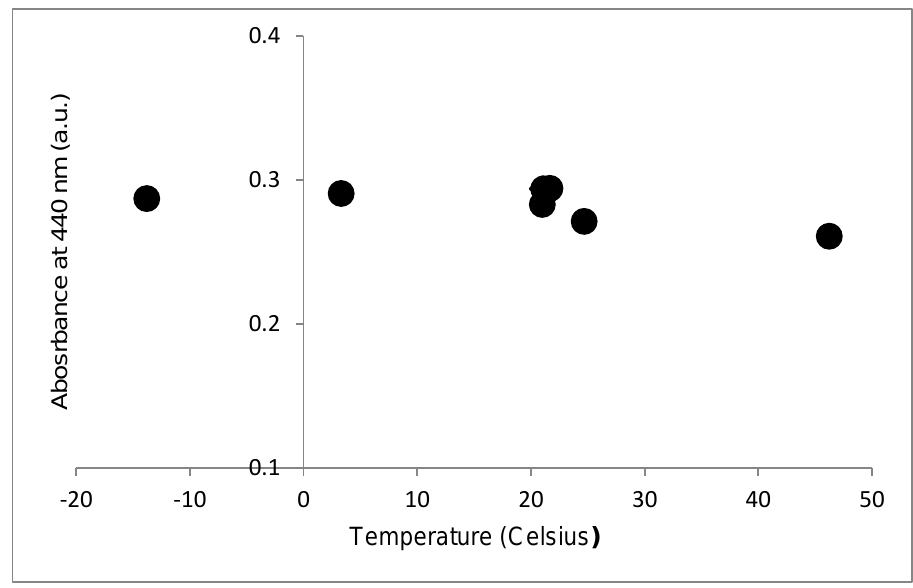
Figure 4. Normalized absorbance of films during thermal treatment at 46.2, 3.3, and −13.7 °C.